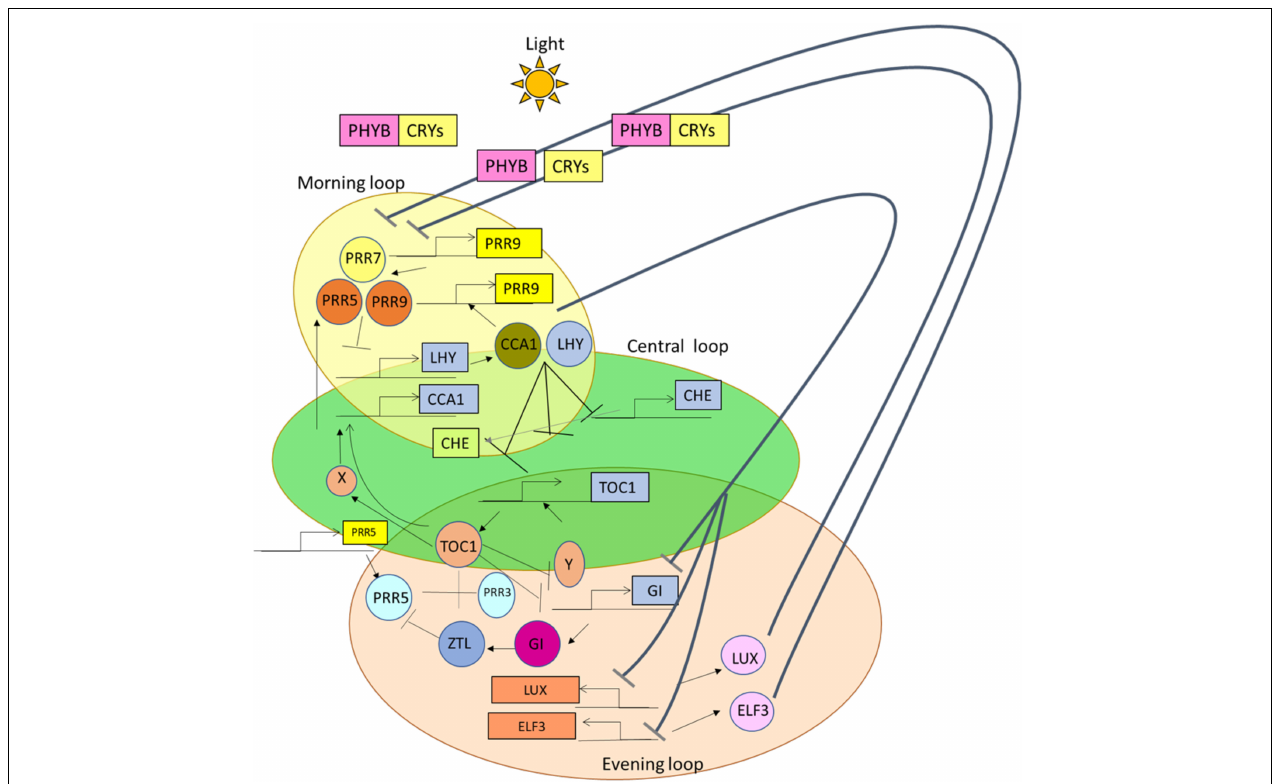
FIGURE 1 | A simplified representation of the suppression of genes having the proteins and photoreceptors present during the functioning of 24 h circadian rhythm. In the presence of light, these photoreceptors Cryptochromes (CRYs) and Phytochrome B (PHY B), which are represented in yellow and pink squares, help in the functioning of genes and proteins; along with the formation of two different negative loops. That is, these morning loop genes [CIRCADIAN CLOCK ASSOCIATED 1 ( CCA1 ) or LATE ELONGATED HYPOCOTYL ( LHY )] combine with Pseudo-Response Regulators ( PRR7 or PRR9 ) and suppress the action of CCA1 or LHY (represented with black lines with arrows). On the other hand, TIMING OF CAB EXPRESSION (TOC1) combines with GI, which then leads to the activation of the TOC1 gene. ZEITLUPE (ZTL) is activated with the help of GI, and then GI itself combines with ZTL and suppresses the function of TOC1 (indicated with the black lines along with